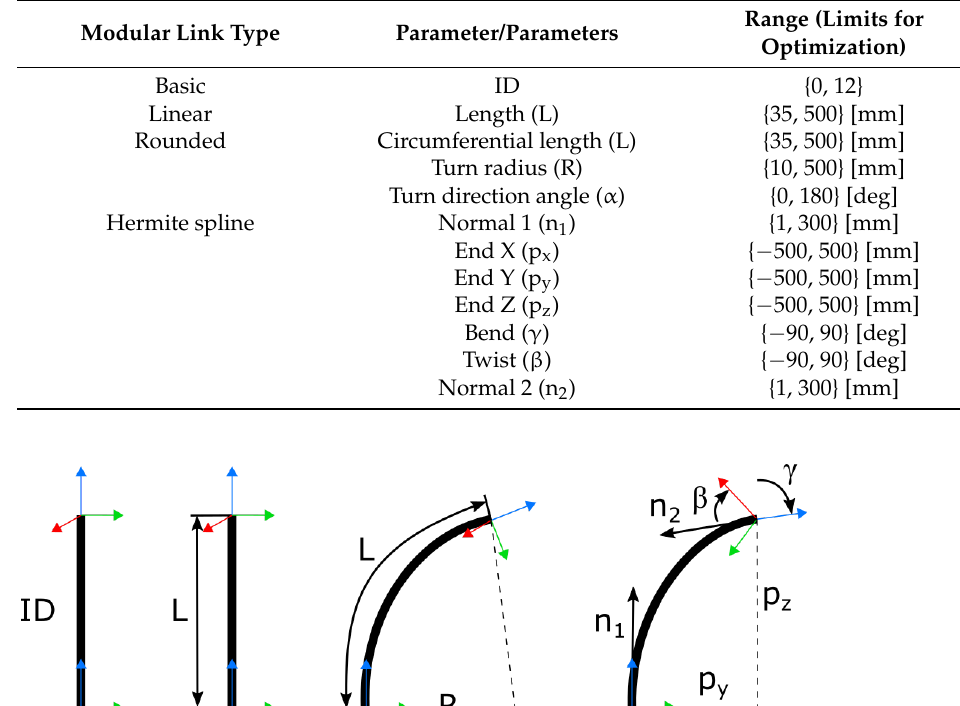
Table 3. Link parameters.